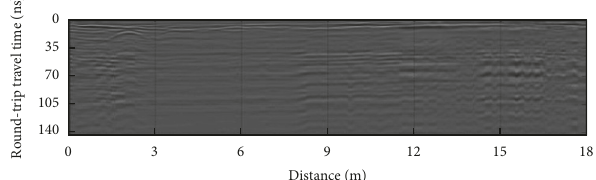
Figure 4: GPR profile of the surveying line.